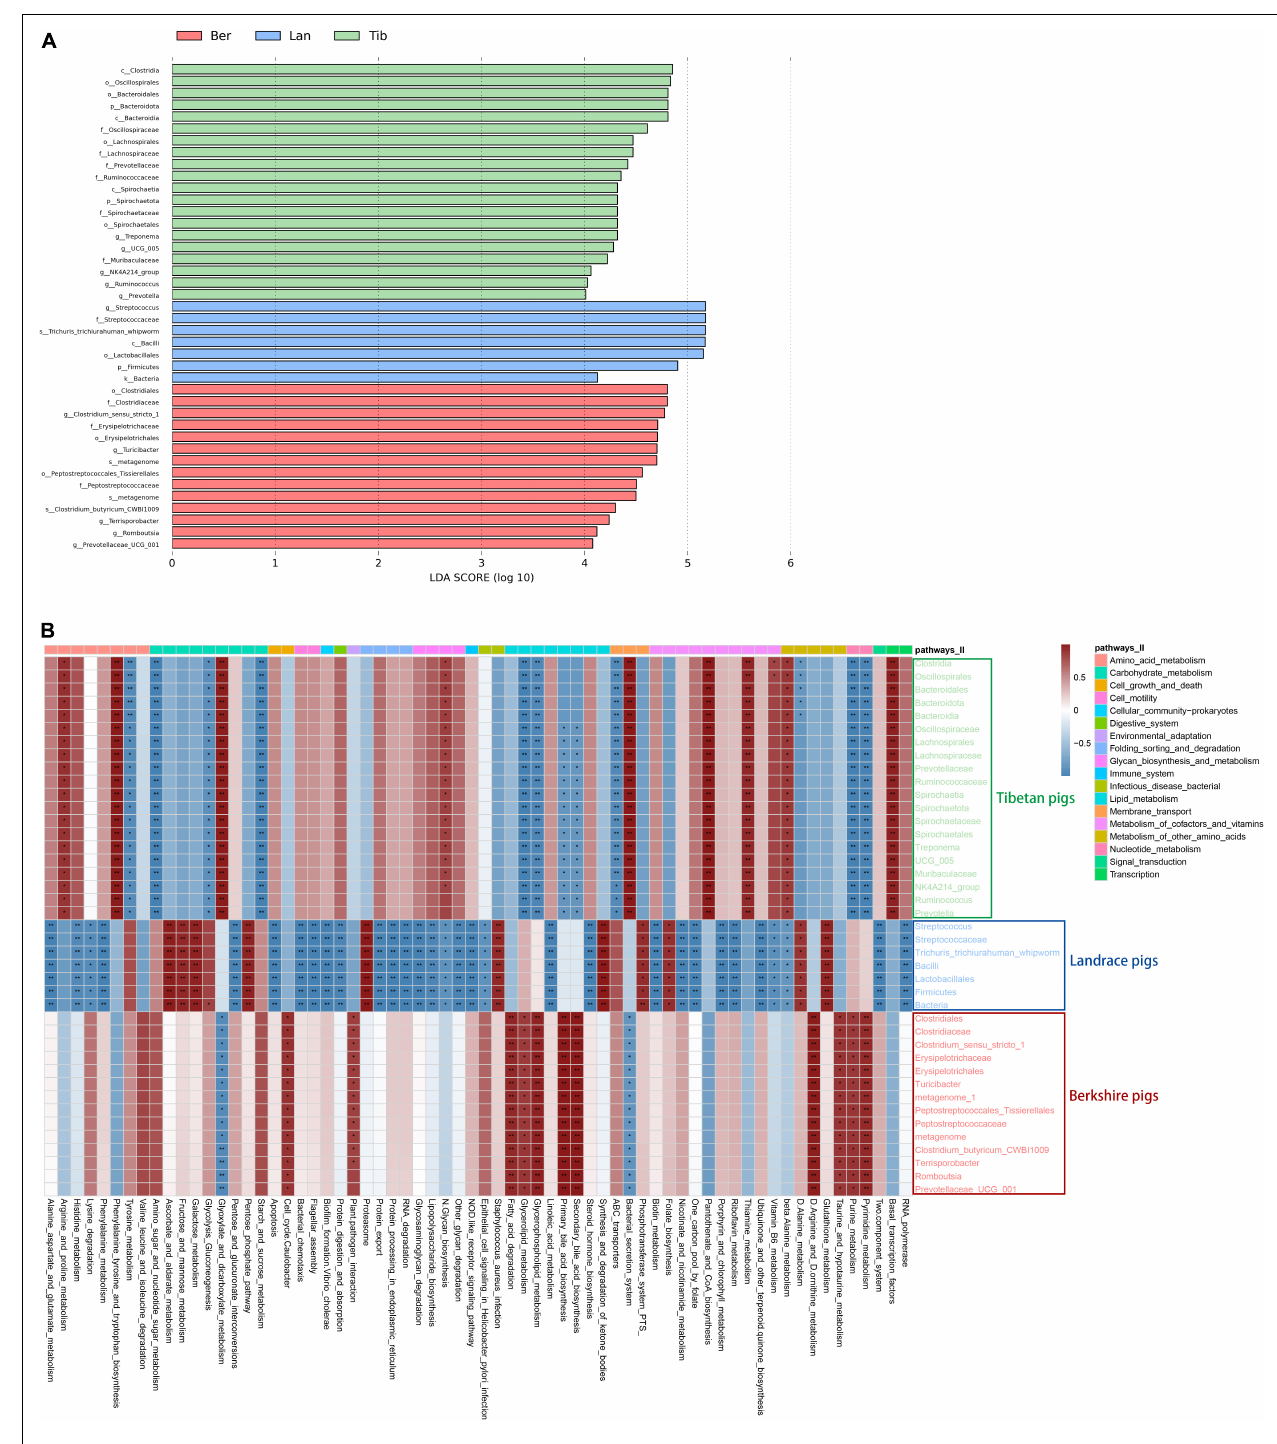
FIGURE 4 | Differences of bacterial species in fecal samples of the three breeds of pigs and heatmap showing the correlation between bacterial species and metabolic pathways. Differences of bacterial species in fecal samples (A) . Green, blue, and red represent the bacterial species in Tibetan, Landrace, and Berkshire pigs, respectively. The picture depicts the third-level metabolic pathways annotated against Kyoto Encyclopedia of Genes and Genomes (KEGG). Different colors in the upper part of the picture represent the third-level metabolic pathways annotated to KEGG. Heatmap of correlation between species and metabolic pathways (B) . Red represents a positive correlation between species and metabolic pathways, and blue represents a negative correlation. The darker the color, the greater the correlations, * p < 0.05, ** p < 0.01.